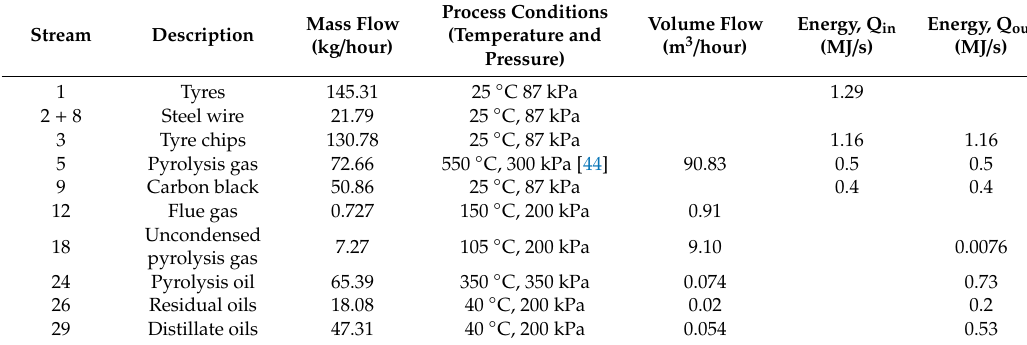
Table 5. Pyrolysis mass and energy balances.